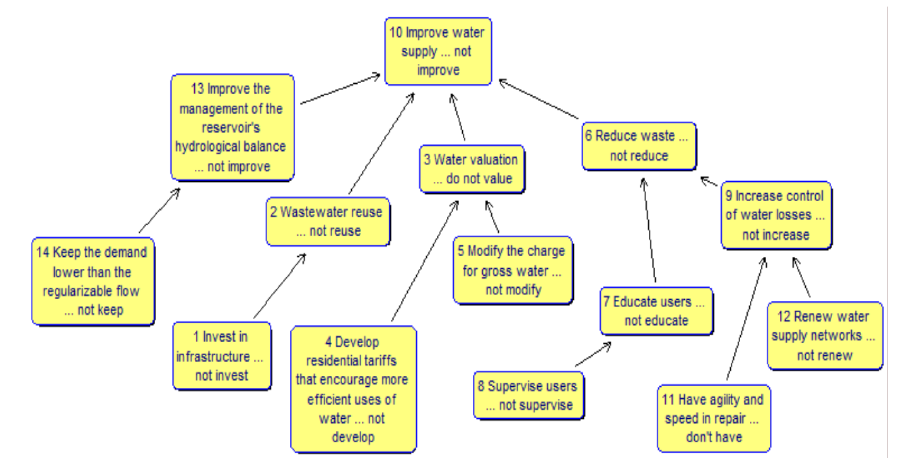
Figure A1. Individual Cognitive Maps of Actor